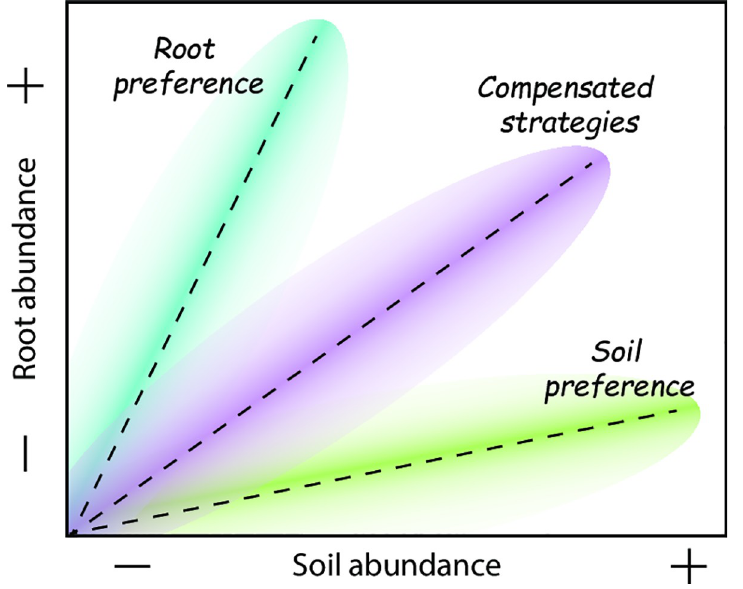
Fig 1. Conceptual scheme indicating possible patterns between the abundance of AMF in roots vs soil compartments. Dotted lines and coloured shapes represent three different scenarios depending on the predominance of AMF taxa with different colonization strategies. A first scenario (green shape) represents an AMF community dominated by species with preference for soil colonization. A second scenario (blue shape) represents an AMF community dominated by species with a preference for root colonization. In a third scenario (purple shape) both root and soil colonization strategies are present but their abundance tends to even out. Finally, a fourth scenario where no relationship is expected (not shown in the graph) if a) community assembly along the plant community is random (no compensated colonization strategies) or if b) the biomass allocation in root and soil of individual AMF taxa is not